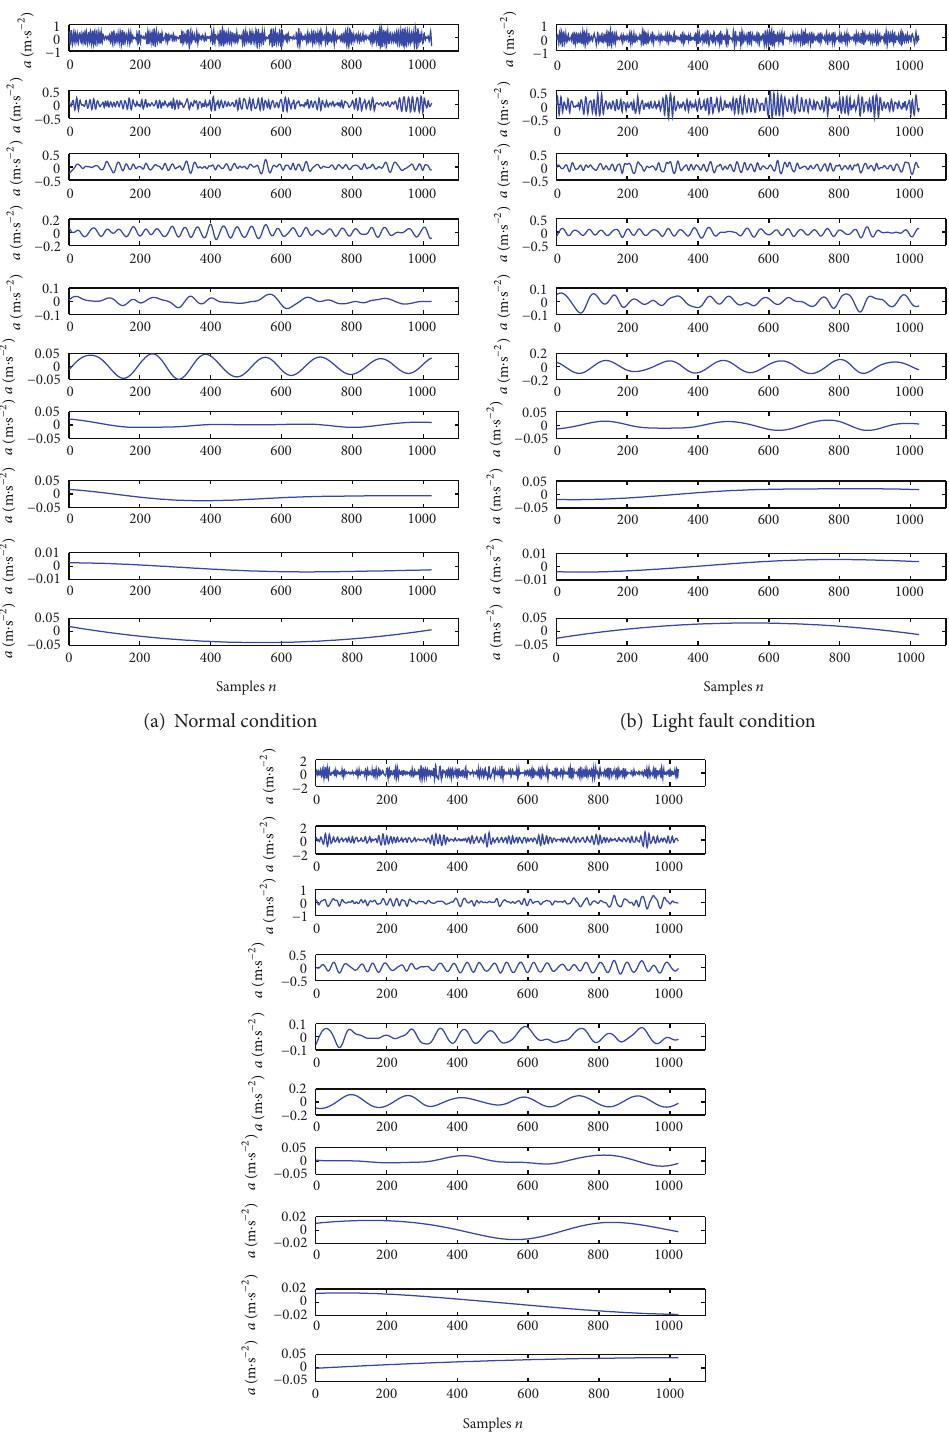
Figure 8: The decomposition result by CEEMD under different